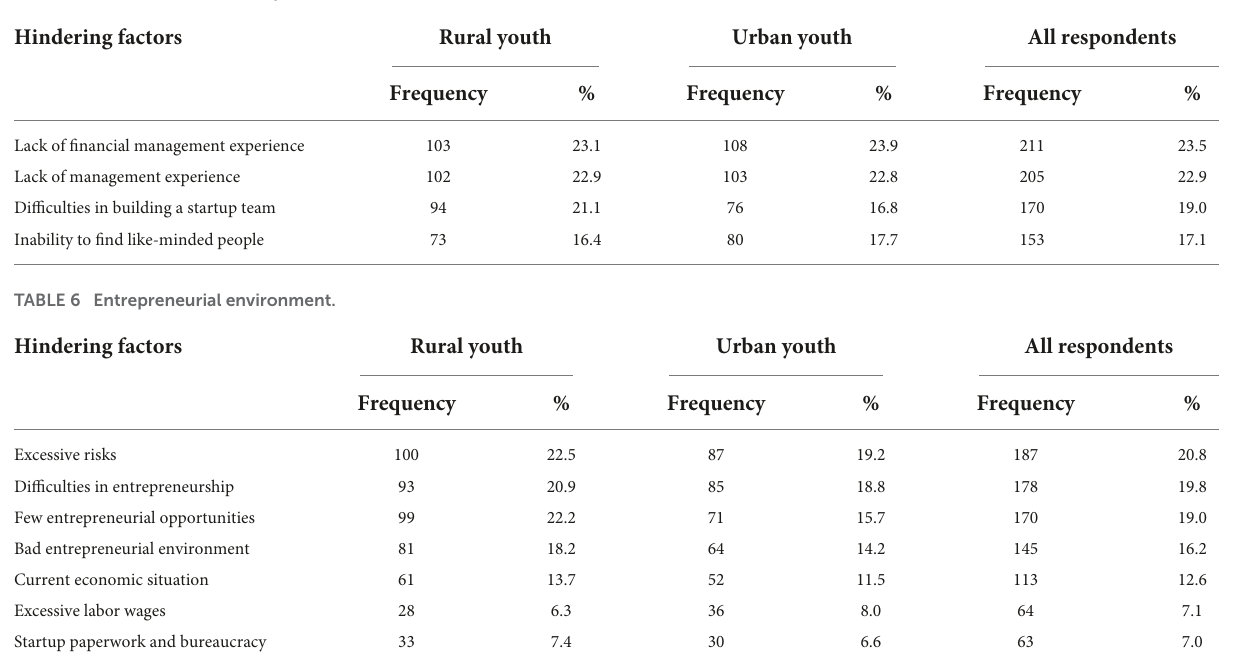
TABLE 5 Team formation and operations.